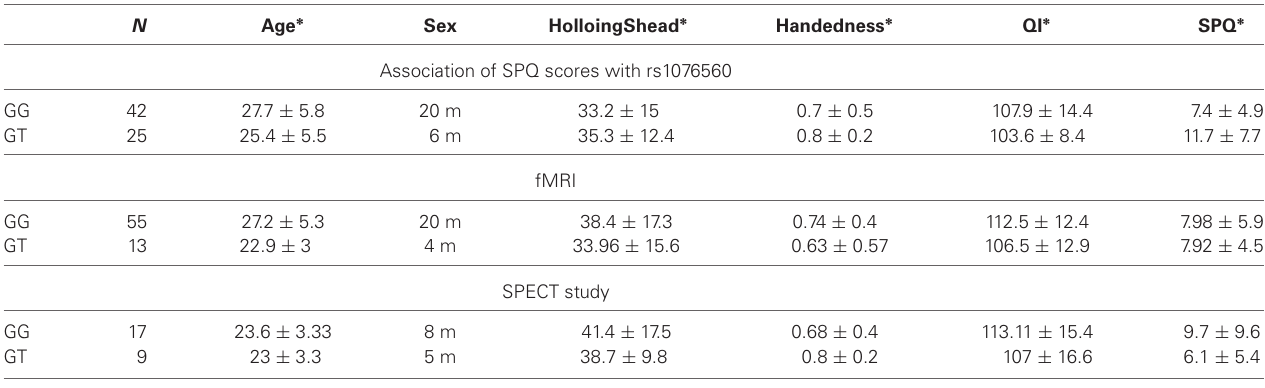
Table 1 | Demographics of the subjects included in the study .